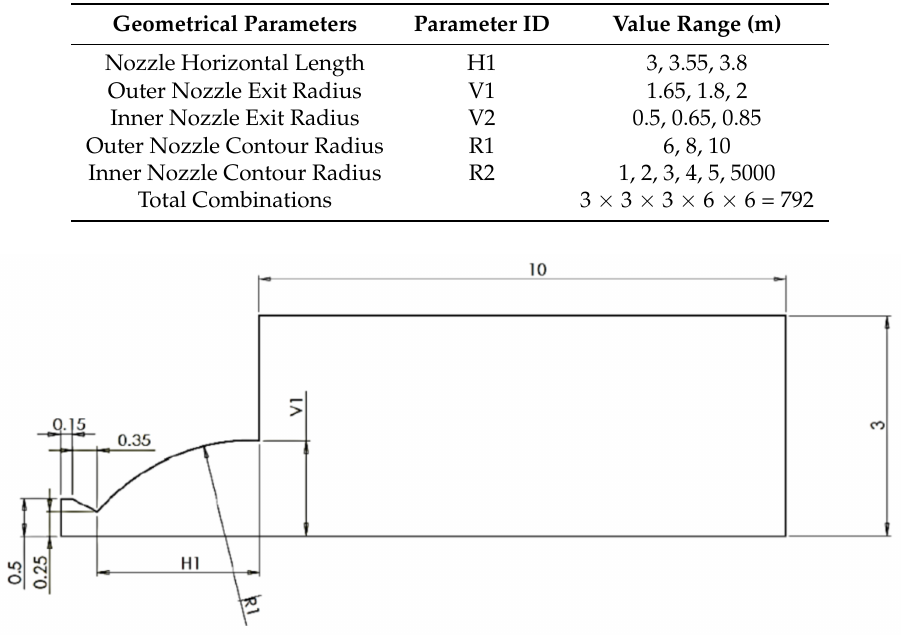
Figure 13. Bell nozzle geometry.